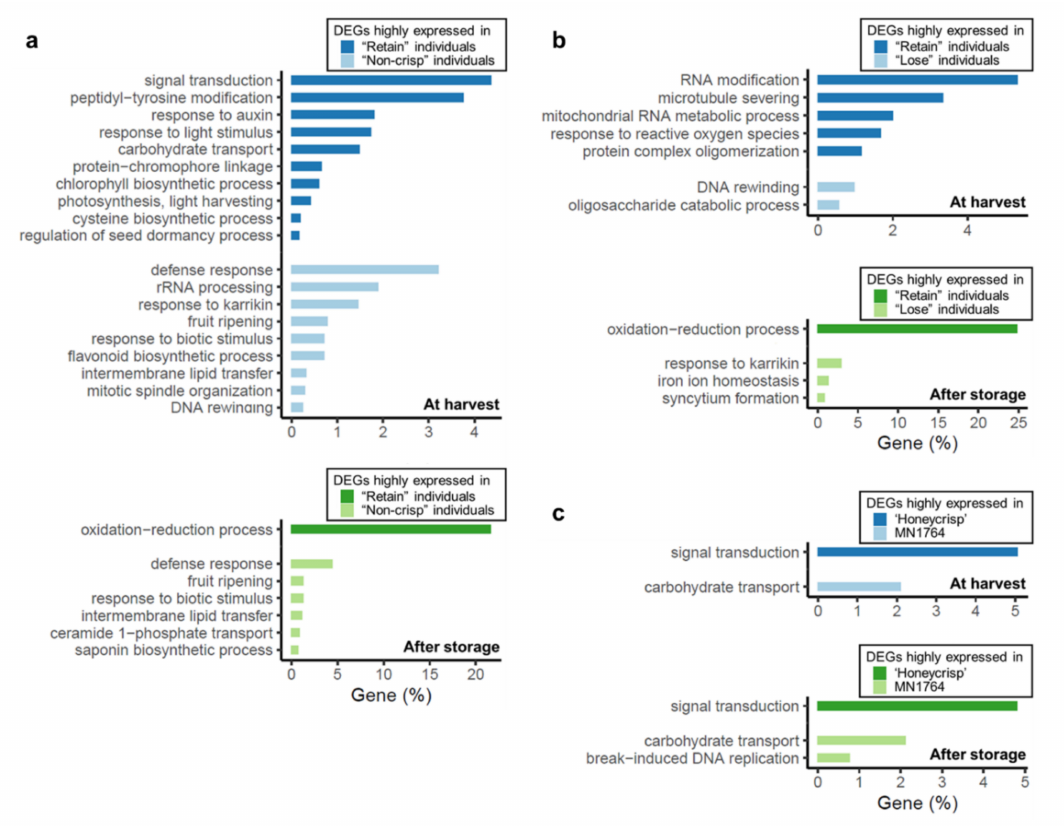
Figure 4. Enriched Gene Ontology (GO) terms associated with the di ff erentially expressed genes (DEGs) distinguished between the ( a ) “Retain” and “Non-crisp” groups, ( b ) “Retain” and “Lose” groups, and ( c ) ’Honeycrisp’ and MN1764 at harvest and after 2-month storage. A false discovery rate (FDR) < 0.05 was used as the threshold for identifying significantly enriched GO